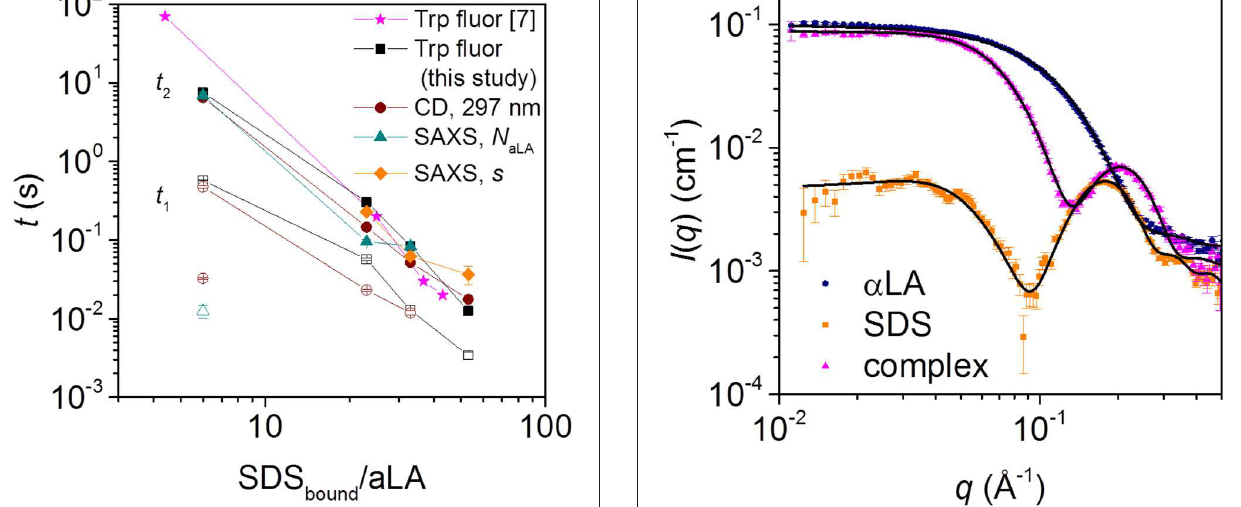
intensity for q